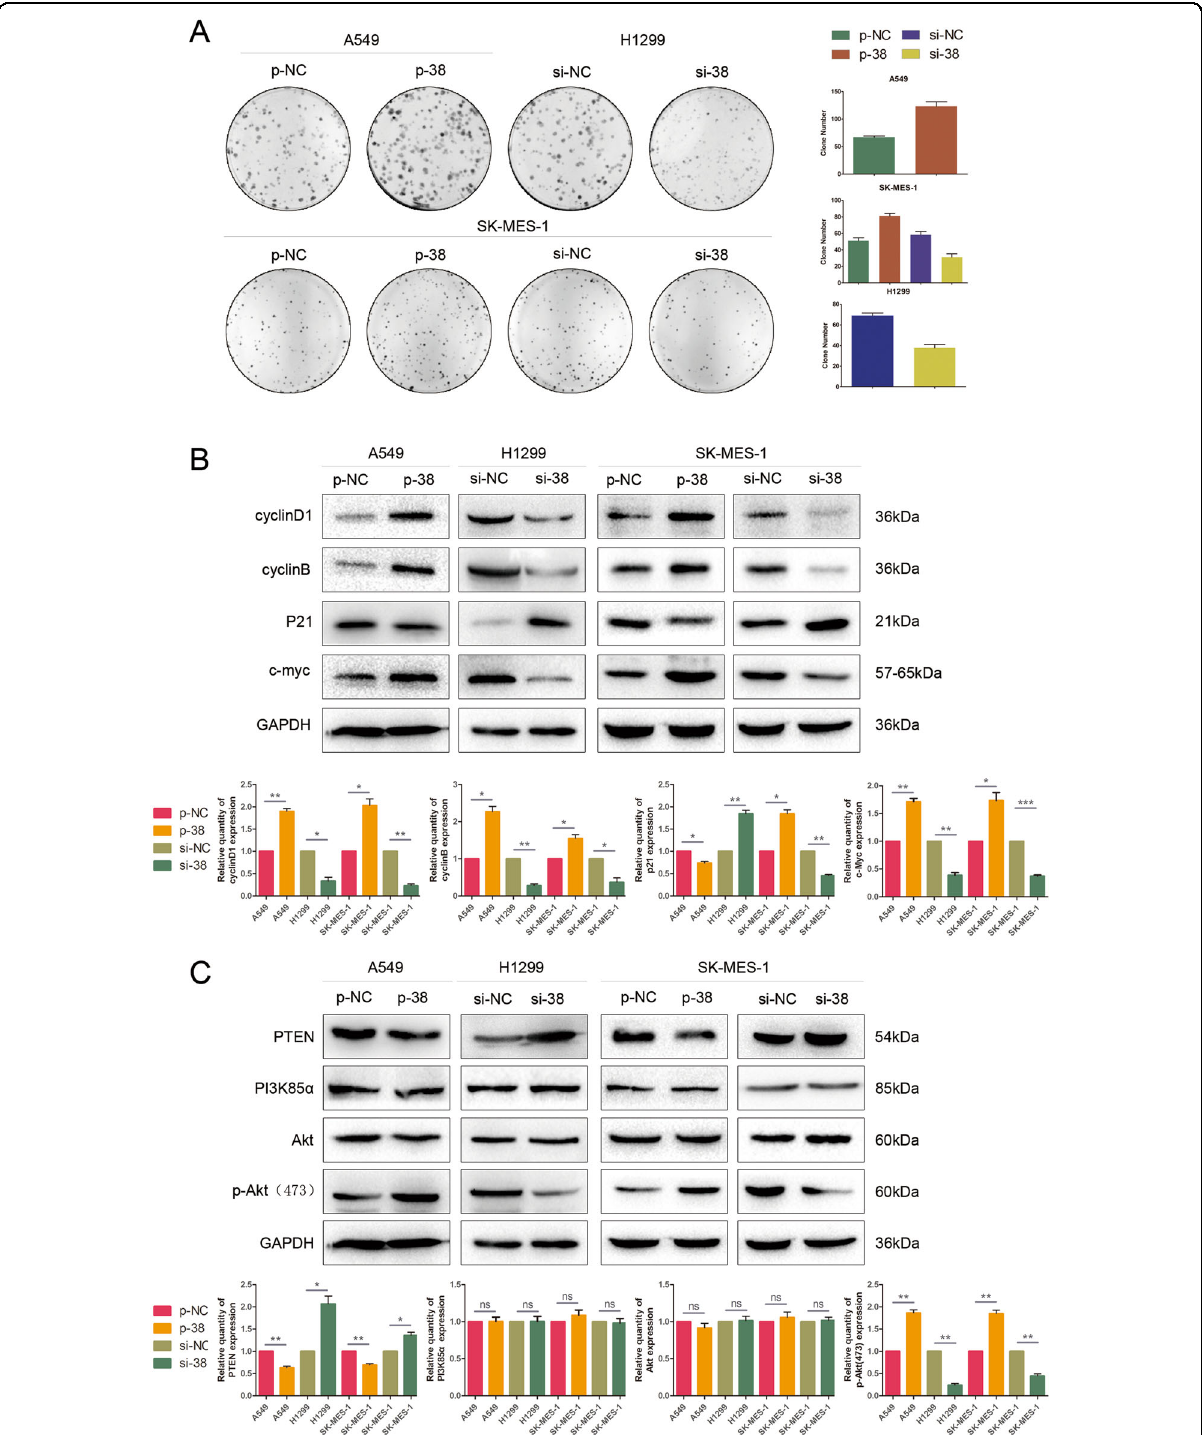
Fig. 3 Effect of KLHL38 expression on colony formation and Akt signaling. A Colony formation assay. A549: pCMV6-myc-DDK- KLHL38 (p-38) vs. pCMV6-myc-DDK (p-NC), P = 0.0278. H1299: KLHL38 -speci fi c siRNA (si-38)vs. scrambled control siRNA (si-NC), P = 0.0189; SK-MES-1: p-38 vs. p-NC, P = 0.0391, si-38 vs. si-NC, P = 0.0318. B Changes in the expression of proliferation-related proteins in A549, H1299, and SK-MES-1 cells. C Changes in Akt signaling in A549, H1299, and SK-MES-1 cells. p-NC, cells transfected with pcmv6-myc-DDK; p-38, cells transfected with pCMV6-myc-DDK- KLHL38 ; si- NC, cells transfected with scrambled control siRNA; si-38, cells transfected with KLHL38 -speci fi c siRNA. All experiments were repeated three times, error bars as